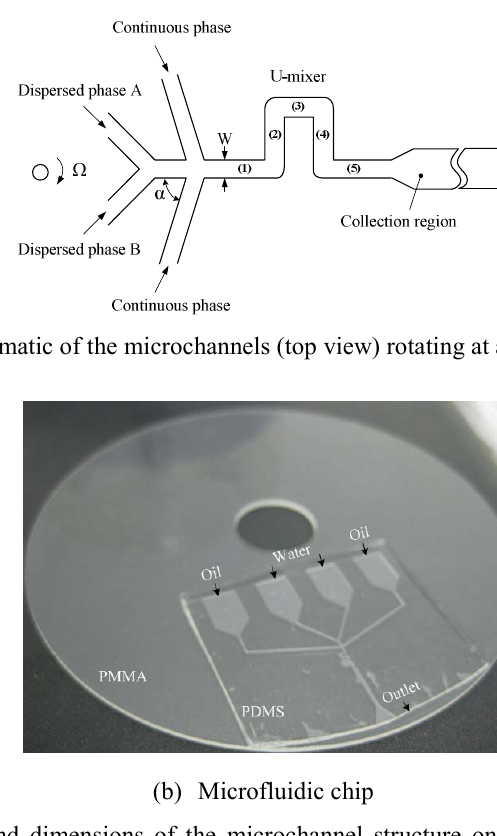
Fig. 1 Geometry and dimensions of the microchannel structure on a rotating disk and a sample of the rotating microfluidics fabricated for experiments.